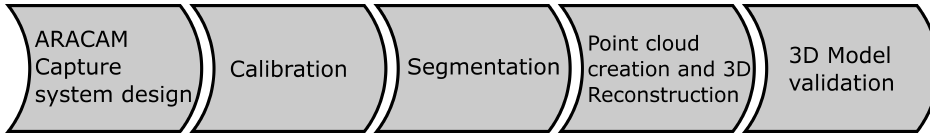
Figure 2. System